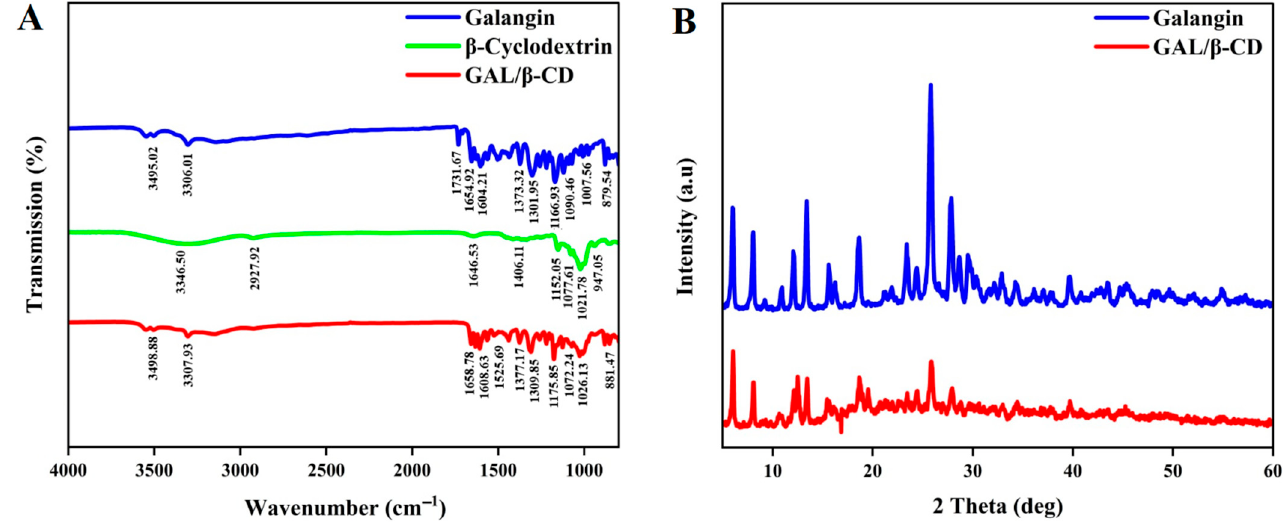
Figure 4. ( A ) Fourier transforms infrared spectroscopic analysis of pure galangin, β -cyclodextrin, and GAL/ β -CD. ( B ) XRD of pure galangin and GAL/ β